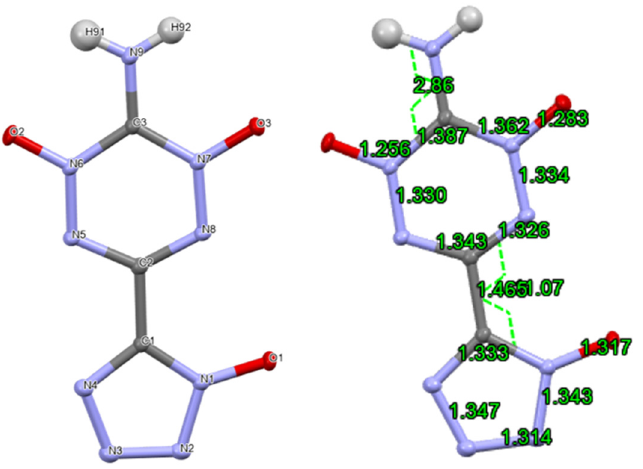
Figure 3. Selected bond lengths in crystal of 11 . The values of the bond lengths are given in angstroms.